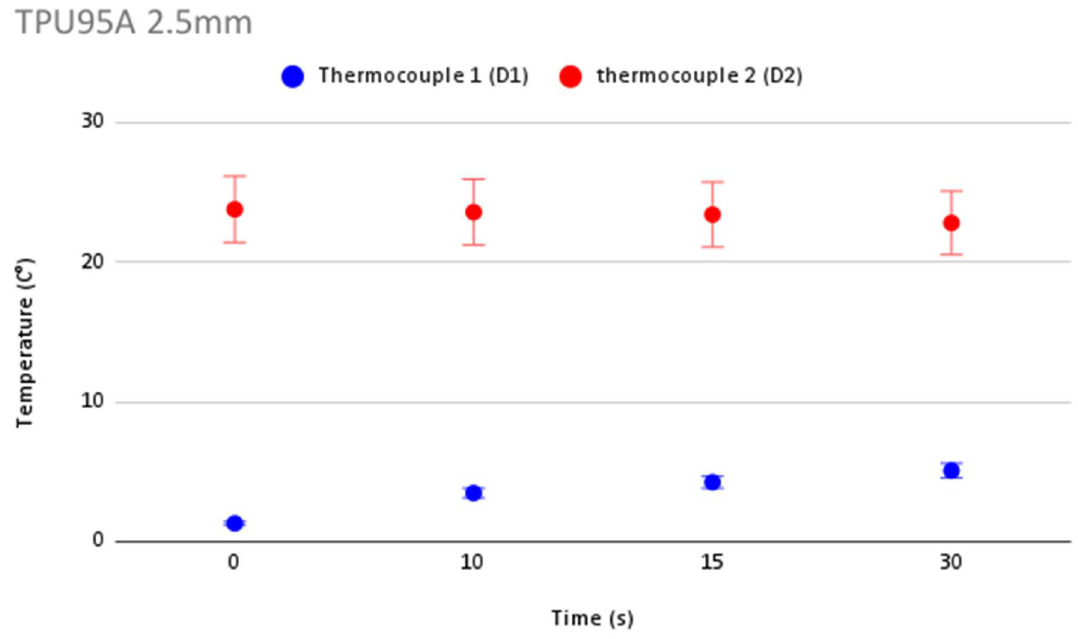
Figure 9. Repeatability of temperature measurements and error bars for TPU95A of 2.5 mm. Repeatability of temperature measurements and error bars for TPU95A of 2.5 mm.